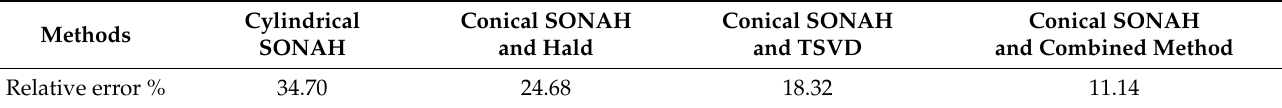
Table 3. Reconstruction error of different regularization